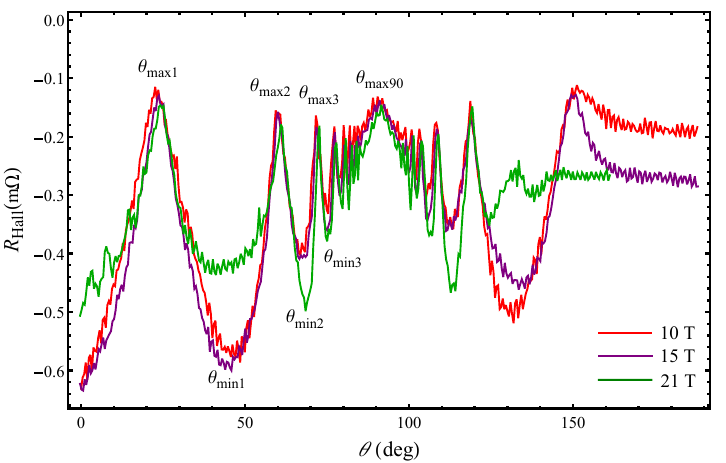
Figure 2. Angular oscillations of the Hall resistance in α - ( BEDT-TTF ) 2 KHg ( SCN ) 4 for several fields: B = 10 T, 15 T, 21 T at T = 0.6 K. The quantum oscillations are visible at each field magnitude in the whole range of angles. The positions of some of the AHROs maxima and minima are indicated.